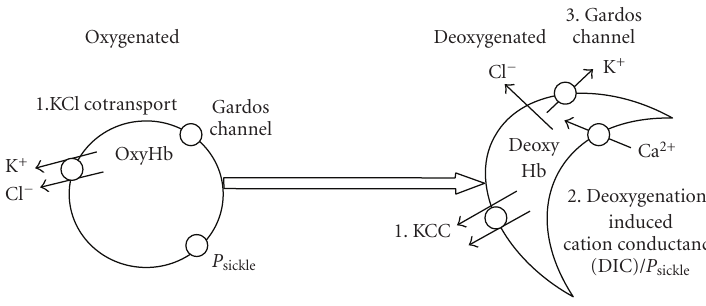
Figure 1: Schematic diagram of the main transport pathways activated in red blood cells (RBCs) from sickle cell patients. In RBCs from homozygous HbSS individuals, high cation permeability is accounted for by three main pathways [28, 37]. Under oxygenated conditions, the KCl cotransporter (KCC) is highly active. It is overexpressed in HbSS cells compared to HbAA ones and does not become quiescent as RBCs mature. It is stimulated further by low pH (reduction in extracelluar pH from 7.4 to 7). Under deoxygenated conditions, KCC remains active—again unlike the situation in HbAA RBCs [40]. In addition, two other pathways are observed. The deoxygenation-induced cation conductance (or P sickle ) is activated as HbS polymerises. It mediates entry of Ca 2+ . Elevation in intracellular Ca 2+ then leads to activation of the third pathway, the Ca 2+ -activated K + channel, or Gardos channel. These three pathways result in solute loss, cell shrinkage and dehydration, and consequent increase in [HbS]. They thereby contribute to pathogenesis of sickle cell disease. They are also likely to be involved in solute loss from RBCs of patients heterozygous for HbS and HbC (HbSC genotype), though details are lacking and di ff erences in their behaviour compared to that in HbSS cells are expected.